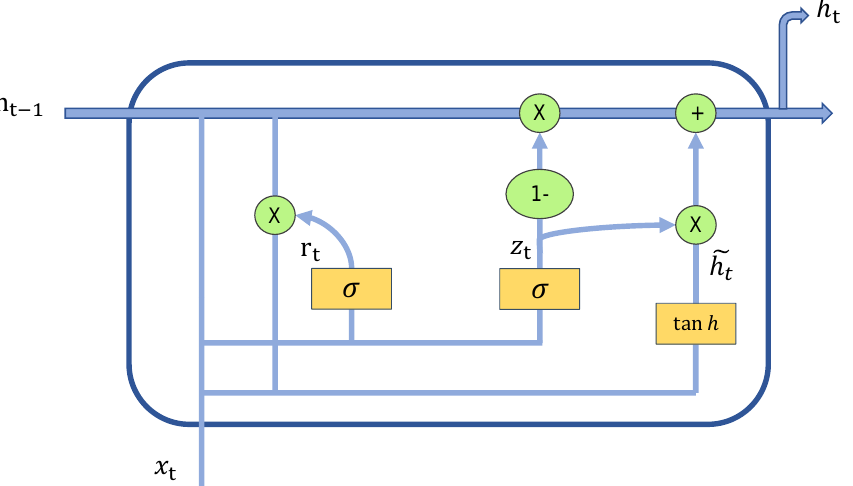
Figure 1. Standard GRU structure.